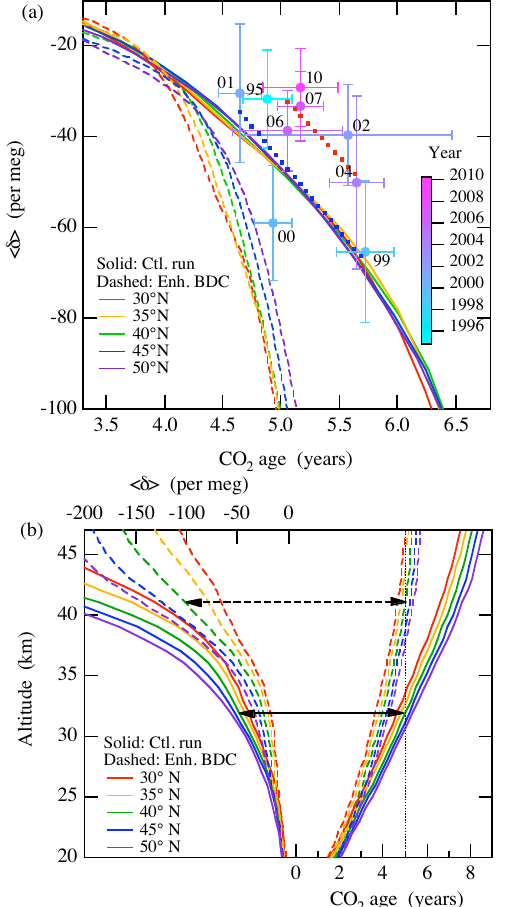
Figure 6. (a) Plots of the < δ > value at 29 km against the average values of CO 2 ages at 2 Fig. 6. (a) Plots of the <δ > value at 29km against the average val- heights above 20-28 km for the respective observations over Sanriku and Taiki, Japan 3 ues of CO 2 ages at heights above 20–28km for the respective obser- (closed circles). Color bar and Arabic numerals near the symbols indicate the observation 4 vations over Sanriku and Taiki, Japan (closed circles). Color bar and years. The results calculated using the SOCRATES model for Control Run (solid lines) 5 Arabic numerals near the symbols indicate the observation years. and Enhanced BDC (dashed lines) are also shown. Blue and red dotted lines represent the 6 The results calculated using the SOCRATES model for Control Run results obtained by applying a linear regression analysis to the data for the respective 7 (solid lines) and Enhanced BDC (dashed lines) are also shown. Blue periods 1995-2001 and 2004-2010. It is noted that the result for 2002 is not used in the 8 and red dotted lines represent the results obtained by applying a lin- ear regression analysis to the data for the periods 1995–2001 and 2004–2010, respectively. It is noted that the result for 2002 is not used in the regression analysis, since the error in the CO 2 age es- timated for that year is significantly larger compared to the other years due to large variability in the vertical CO 2 profile observed in that year. It is also noted that the observed <δ > values at 29km, which is approximately the highest altitude covered by all our ob- servations, are the values obtained by applying linear least squares fits to the vertical <δ > profiles for the respective years, and their error bars denote standard deviations ( ± 1 σ ) of the <δ > values from the respective fitted lines. On the other hand, since the vertical gradients of the CO 2 age are not significant above 20–28km, we use the average values of CO 2 ages above these altitudes. (b) Verti- cal profiles of the <δ > values and the CO 2 ages calculated using the SOCRATES model for Control Run (solid lines) and Enhanced BDC (dashed lines). Black solid (dashed) line denotes the <δ > values for the CO 2 age of 5yr at 40 ◦ N for Control Run (Enhanced